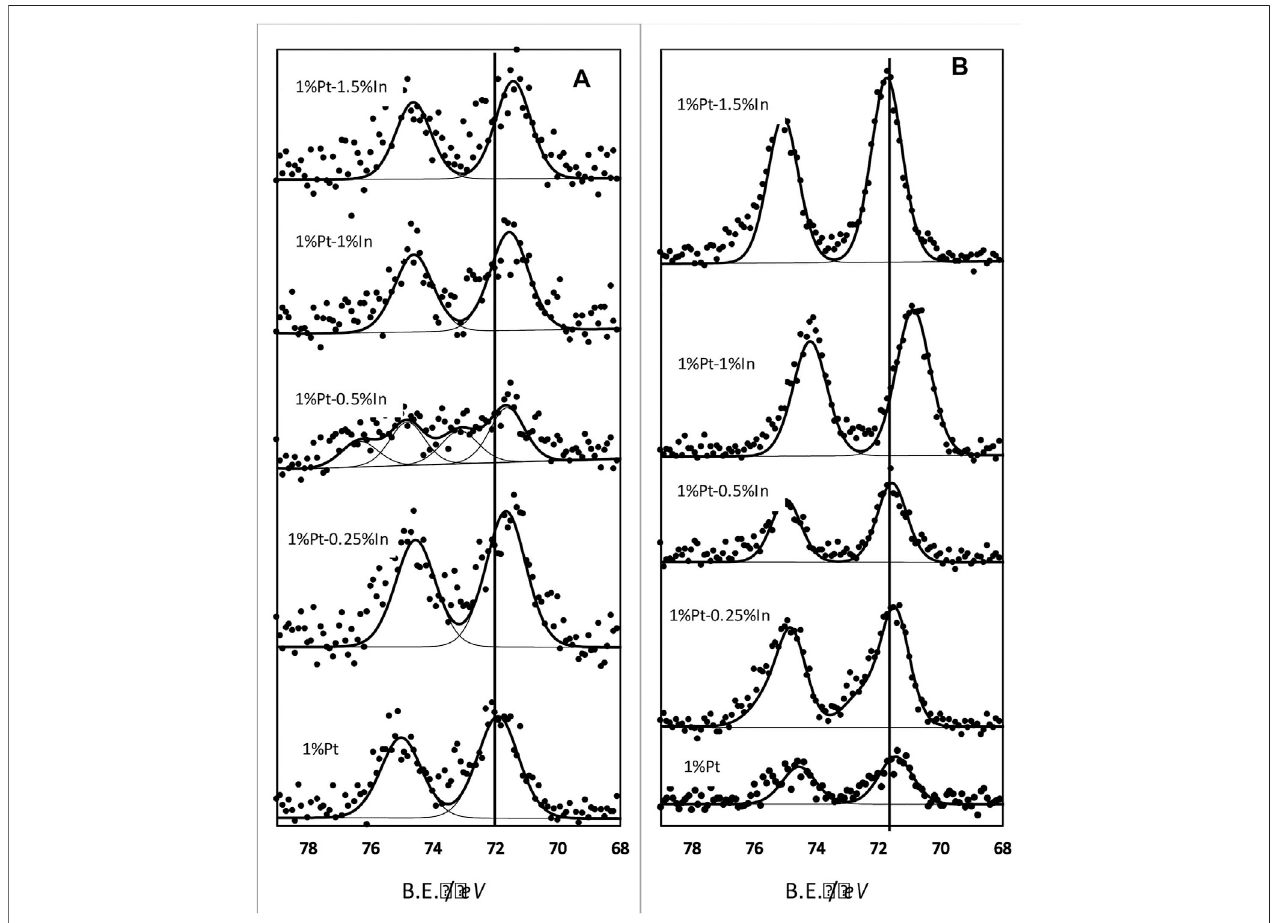
FIGURE3| Pt4 f corelevelspectraofthedifferentcatalysts: (A) samplestreatedat400 ° CinN 2 (B) samplestreatedat400 ° CinN 2 andfurtherreducedinhydrogen at 400 ° C.